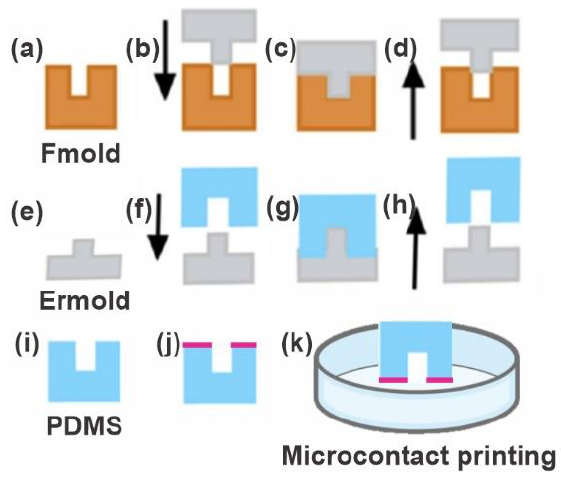
Figure 1. PDMS stamp fabrication. ( a ) Photopolymer flexographic master mold (Fmold). ( b , c ) The epoxy resin mold (ERmold) is formed on the Fmold and cured at room temperature. ( d , e ) The ERmold is demolded after 72 h. ( f , g ) The PDMS is cast on the ERmold and cured at 40 °C overnight. ( h , i ) The PDMS replica is peeled off. ( j , k ) The PDMS stamp is used for microcontact printing.